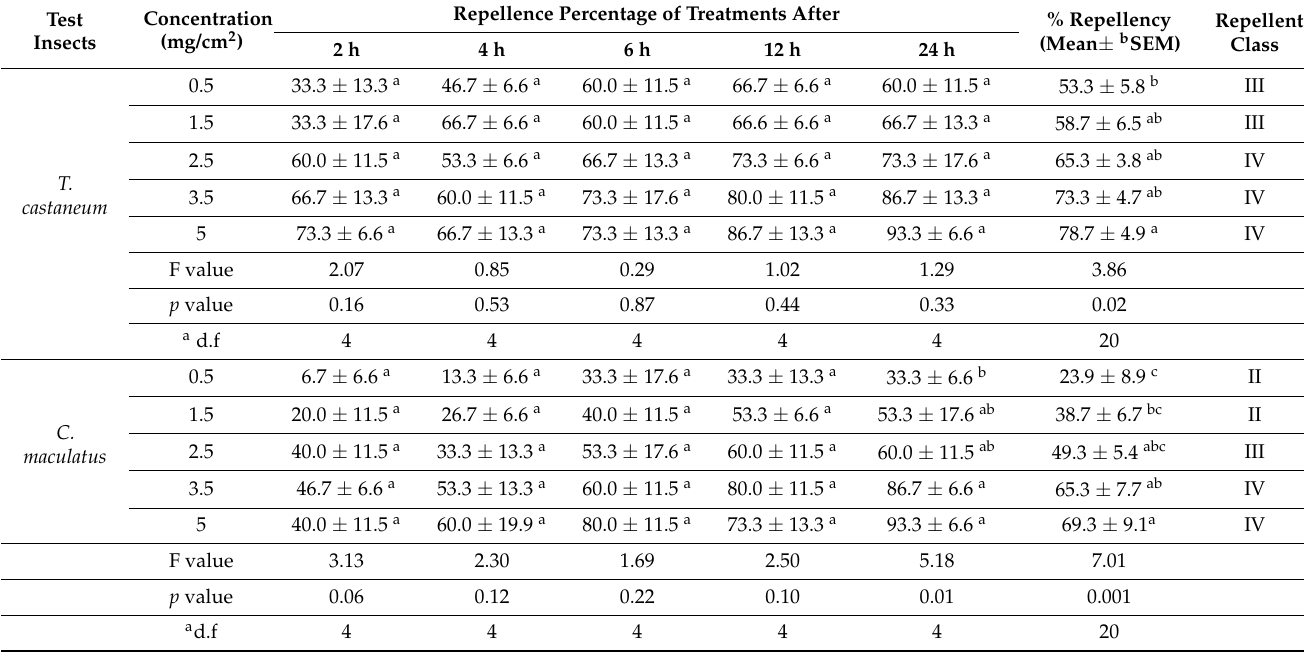
Table 4. Repellecy of CMEO against pests of stored grains at different exposure times.